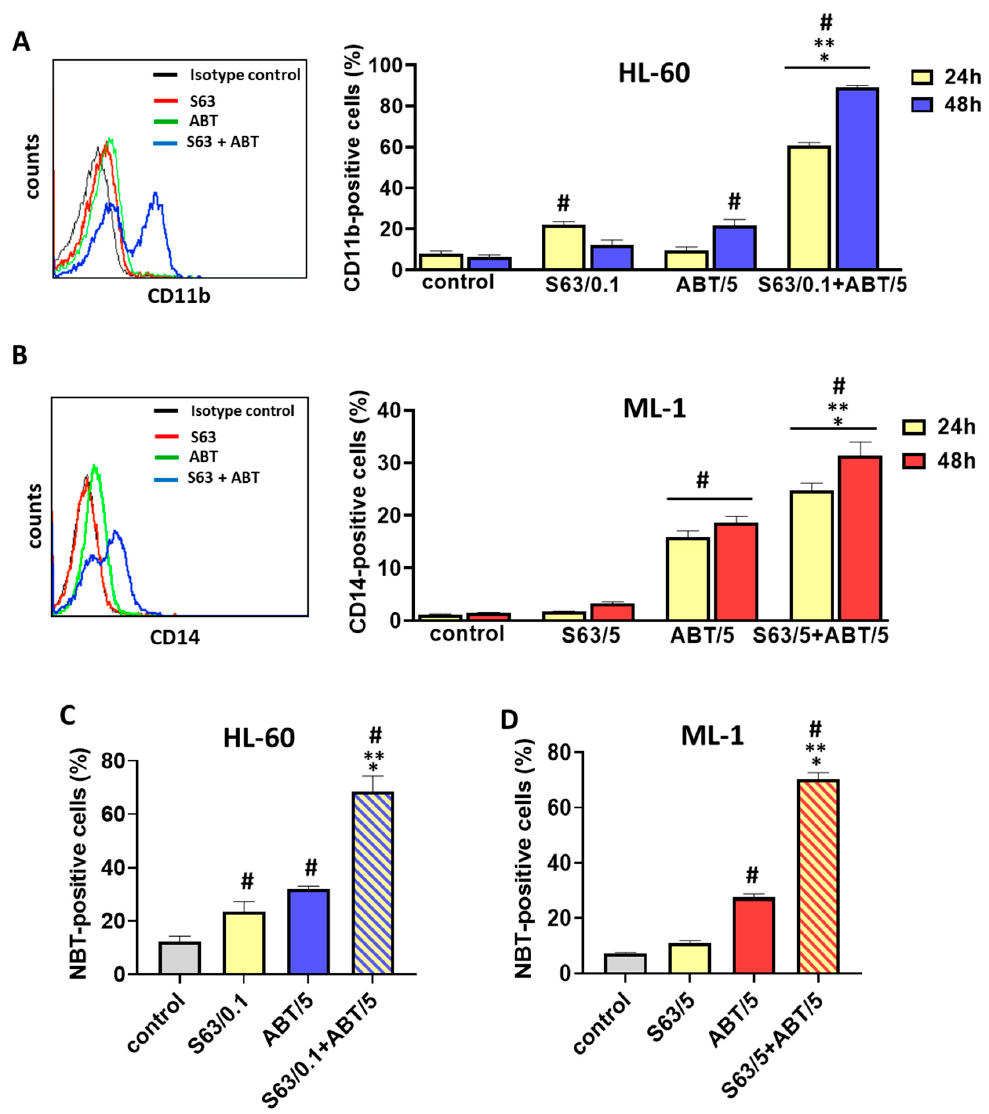
Figure 5. The effects of S63845 (S63) applied alone or in combination with ABT-737 (ABT) on differentiation of AML cells were evaluated 24 h and/or 48 h after cell exposure to the tested agents. ( A ) The percentages of CD11b-positive HL-60 cells and ( B ) the percentage of CD14-positive ML-1 cells were analyzed using fl ow cytometry. A and B left panels—the representative histograms of the ex- pression of CD11b and CD14, respectively. Changes in the percentages of HL-60 ( C ) and ML-1 ( D ) cells performing oxidative burst (NBT-positive cells) were assessed at the 48 h time point using the NBT assay. Designations 0.1 and 5 indicate the agent concentrations (µM). Values are reported as the means ± SD of three independent experiments. Values signi fi cantly di ff erent ( p ˂ 0.05) according to one-way ANOVA are designated by * and ** compared to, respectively, S63845 or ABT-737— single treated group; # compared to the corresponding control. 2.4. S63845 Alters the Expression of MCL-1 on Protein Level When Given in Combination with ABT-737